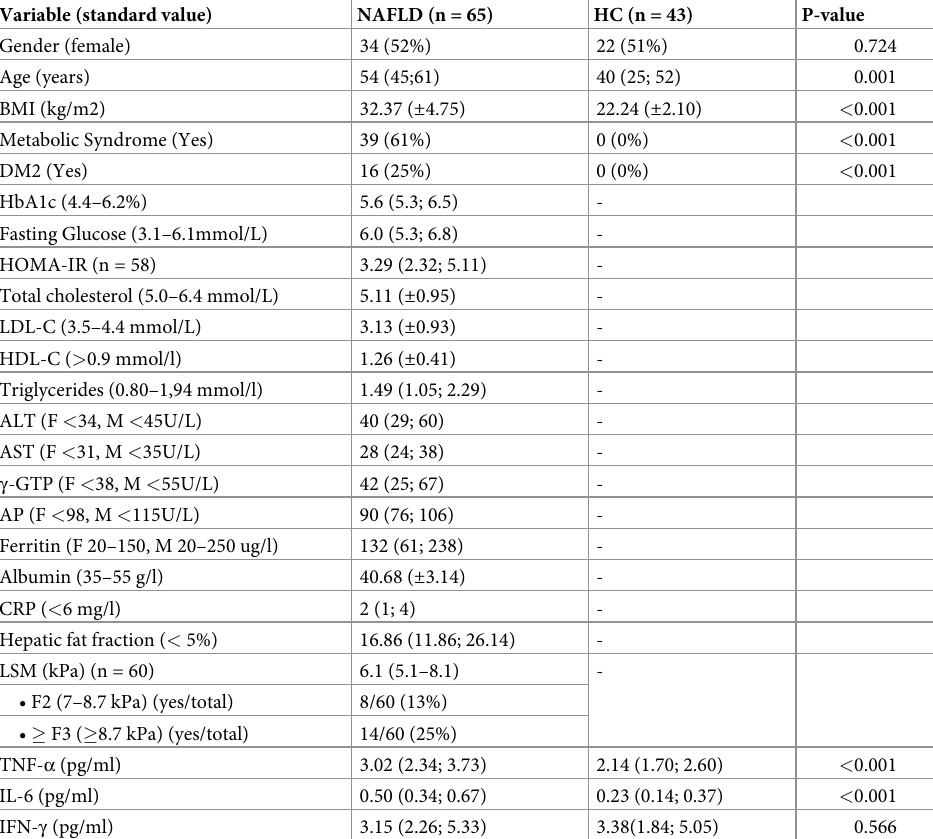
Table 1. Baseline characteristics.